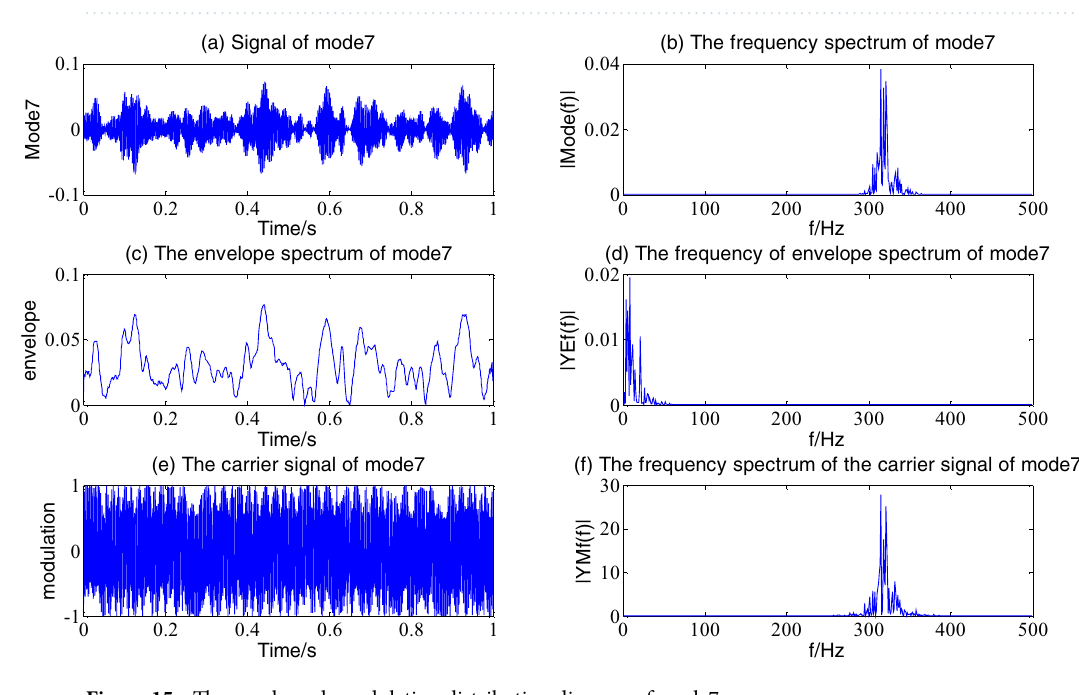
Figure 15. The envelope demodulation distribution diagram of